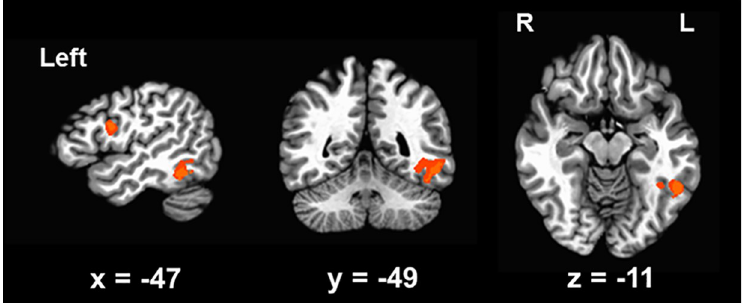
Fig 2. Results of whole brain analyses from combining Experiment 1 and 2. The effect of embeddedness is revealed by the Embedded > Unrelated contrast, which yields enhanced fMRI responses in the VWFA and left